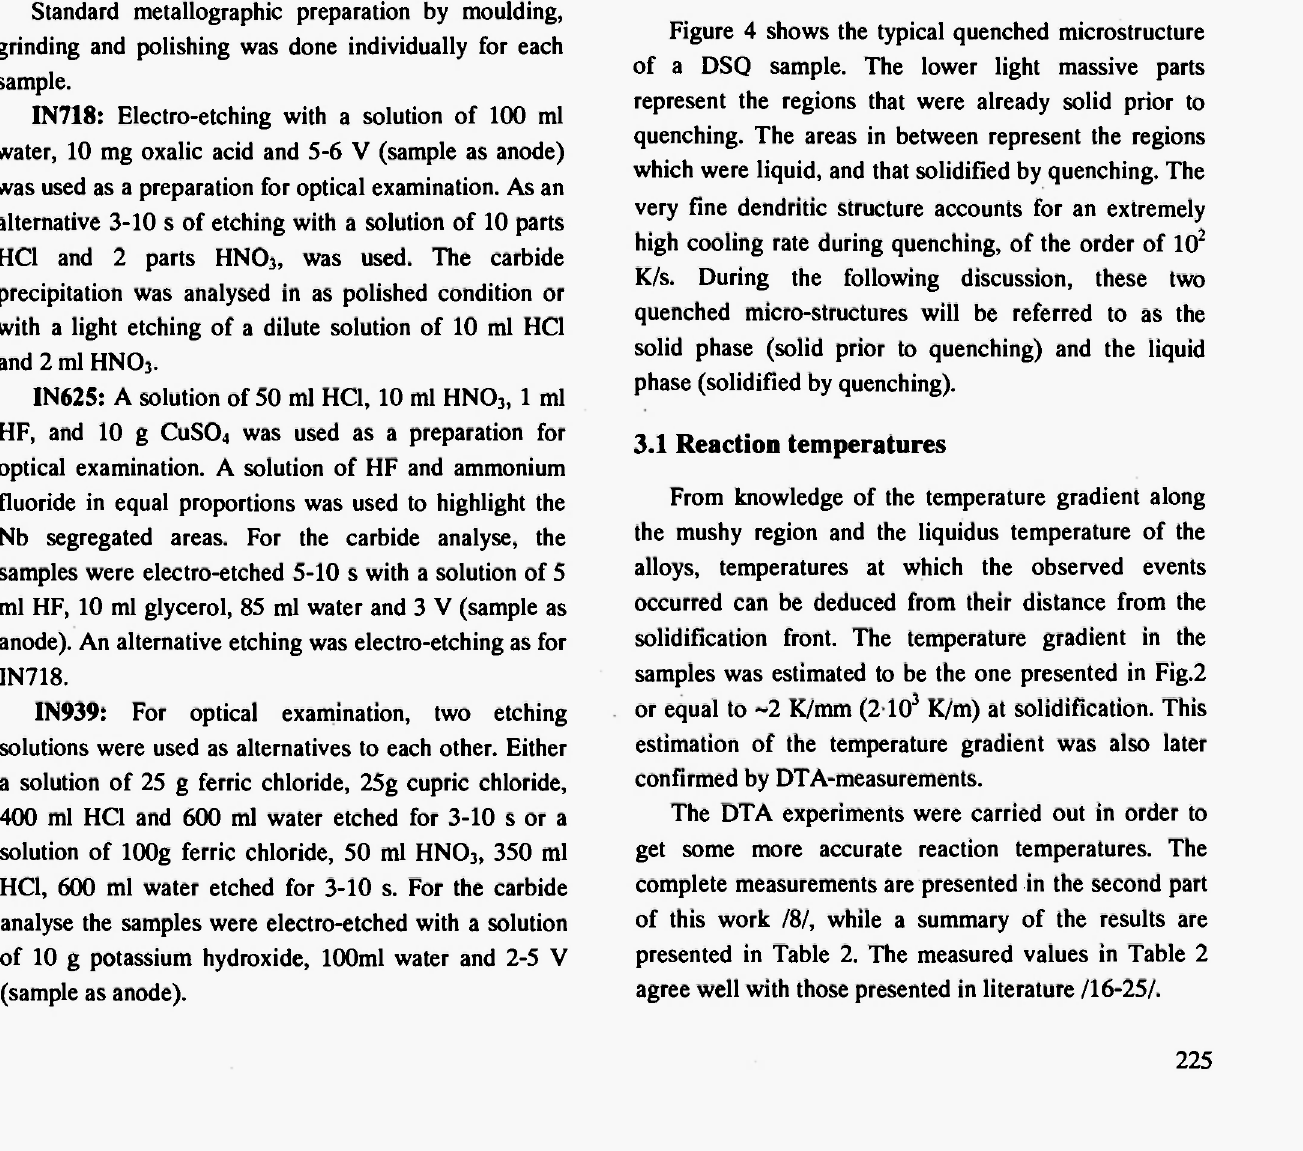
Fig. 3: The experimental setup for DTA